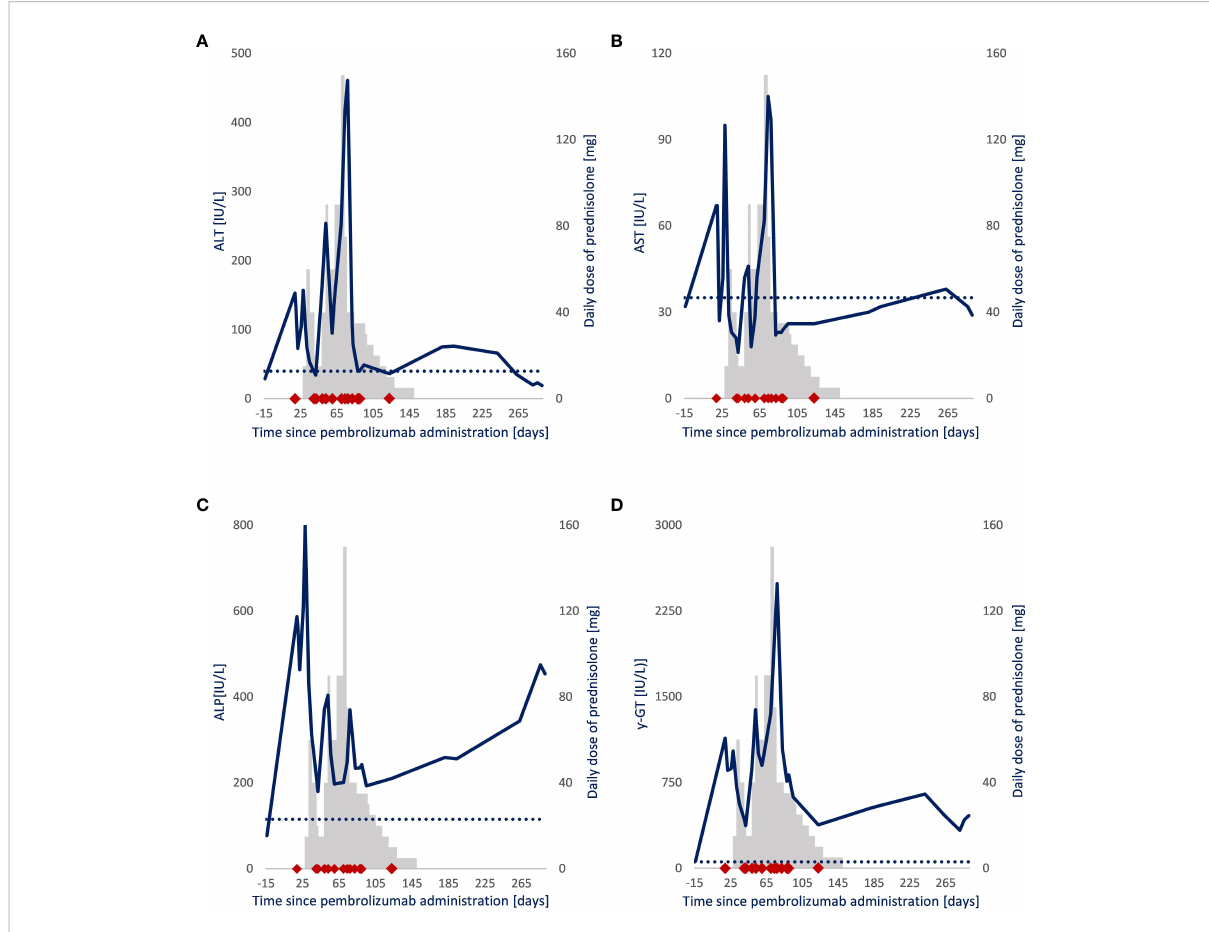
FIGURE 2 Follow-up of liver enzyme levels and daily prednisolone dose in a patient with NSCLC. Blue line: (A) Alanine aminotransferase (IU/L), (B) aspartate transaminase (IU/L), (C) alkaline phosphatase (IU/L), (D) g -glutamyl (IU/L) transferase. Gray bars: Daily prednisolone dose (mg). ◆ : Sample drawn for pembrolizumab quanti fi cation after pembrolizumab administration. ··· : Upper boundary of the liver enzymes ’ normal